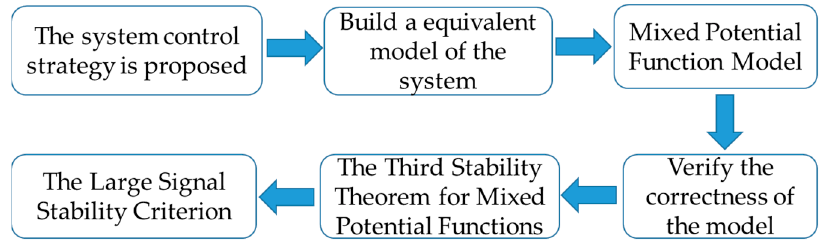
Figure 11. Procedure of large-signal stability method.